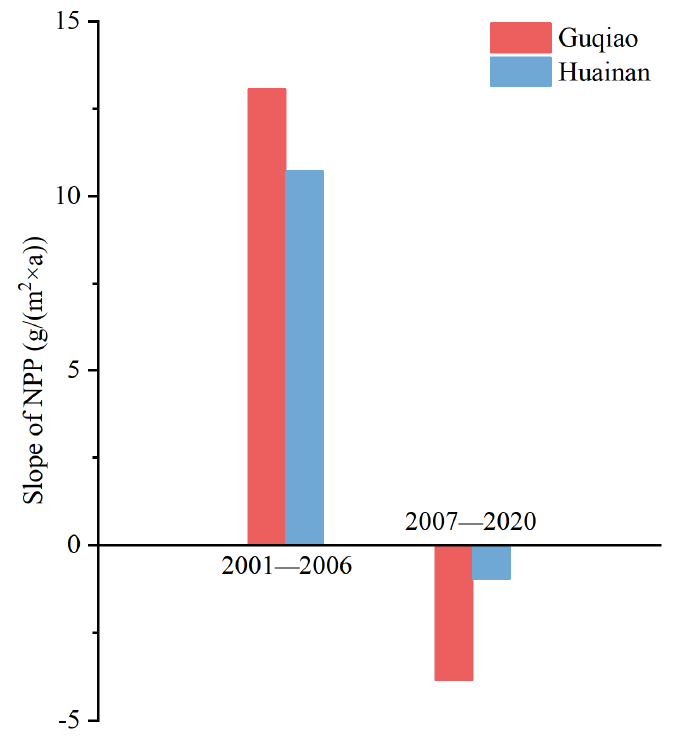
Figure 7. Guqiao mine and Huainan NPP change trend in two stages.